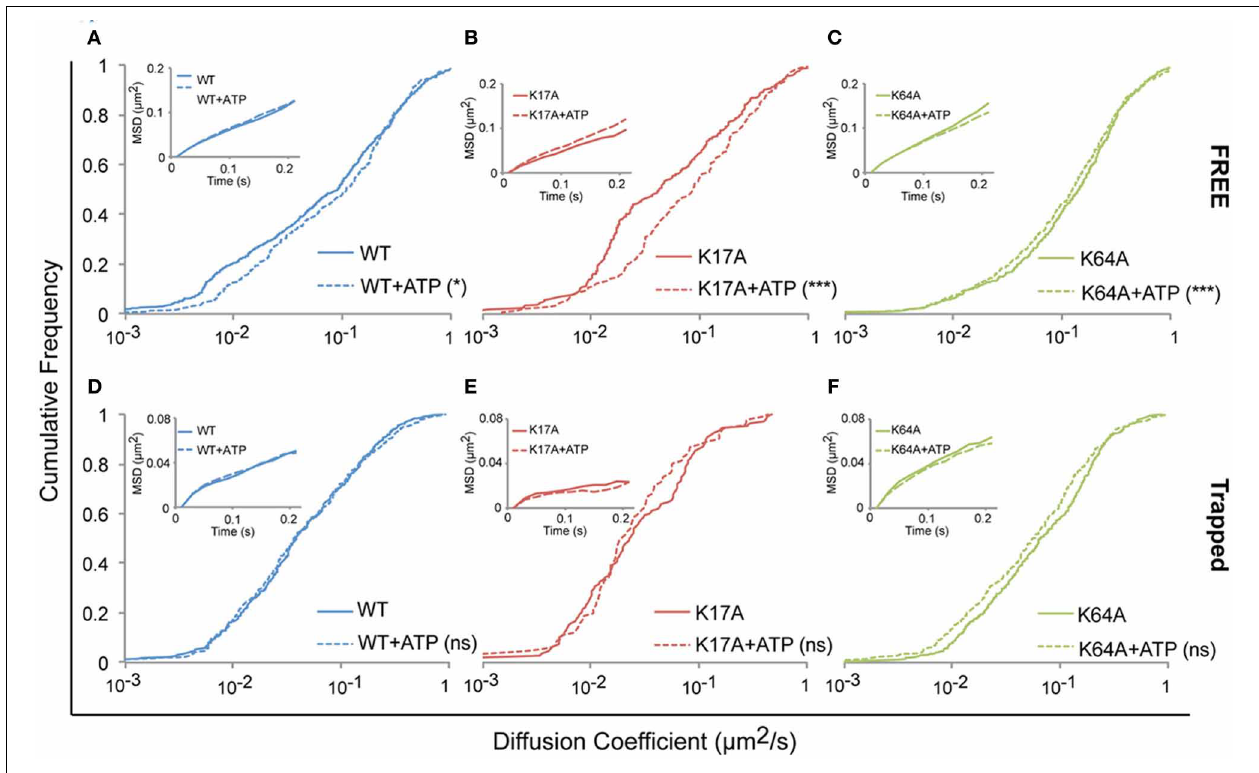
FIGURE 5 | ATP increased the mobility of P2X7Rs. Live cell sptPALM was performed either in the absence or presence of ATP (100 μ M) in recording medium. ( A–C , Table 1 ) ATP differentially increased the diffusion coefficient of “free” WT and K17A-mutant P2X7Rs but not of K64A-mutant receptors. ( D–F , Table 1 ) No